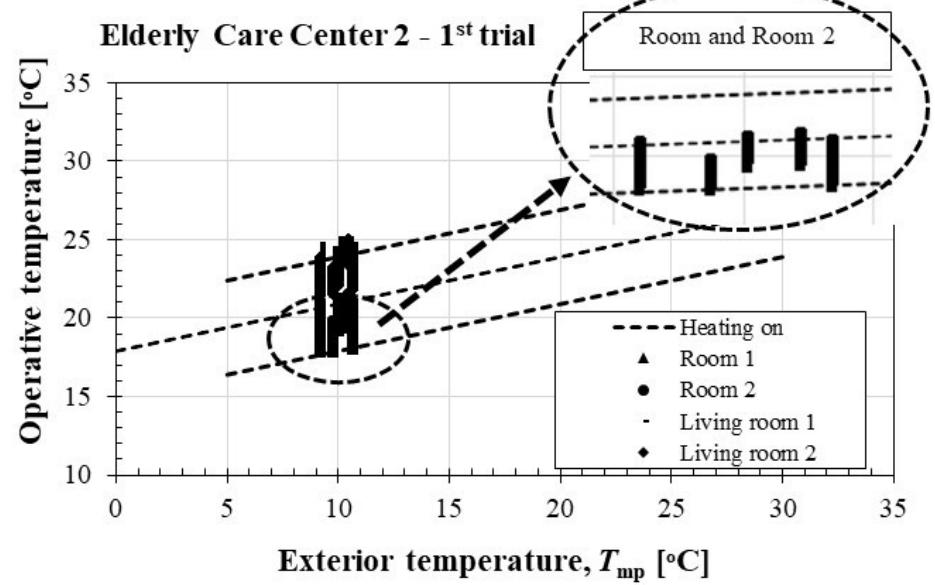
Figure 3. Assessment of thermal comfort by the adaptive method of the LNEC in ECC 2: 1 st trial.